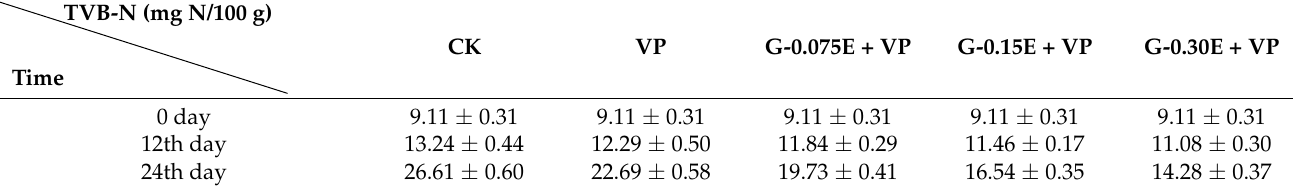
Table 1. The total volatile basic nitrogen (TVB-N) value of seabass in different storage